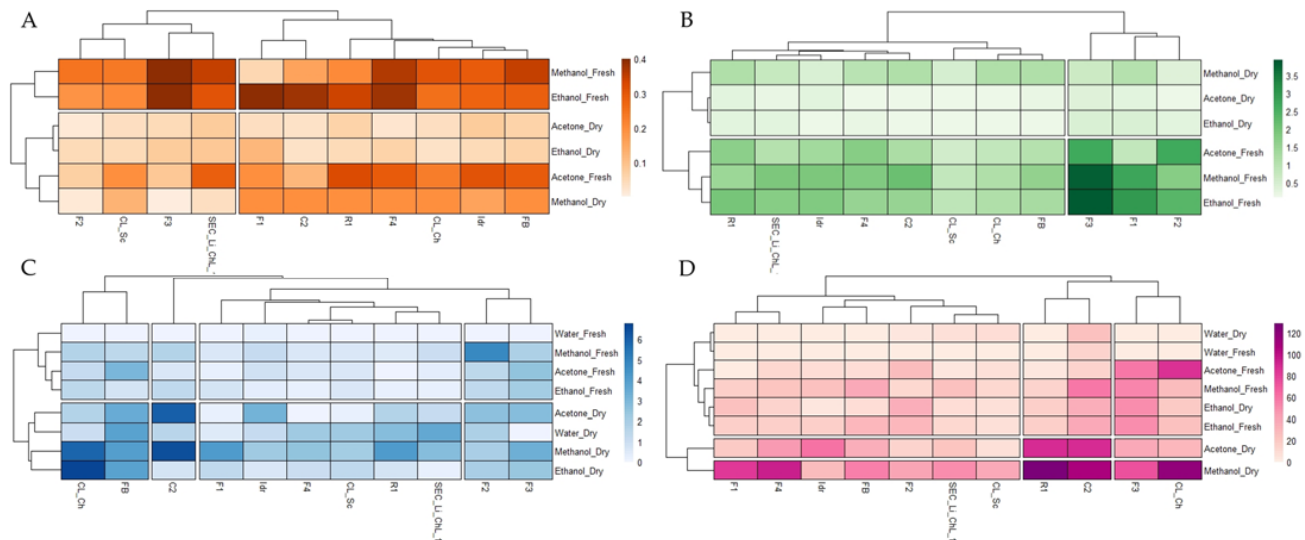
Figure 1. Heatmaps representing the total carotenoid ( A ), total chlorophyll ( B ), polyphenol ( C ), and flavonoid ( D ) content of the microalgal strains under different treatments and solvents. Each datum was obtained from the averaged values of three replicate measures.